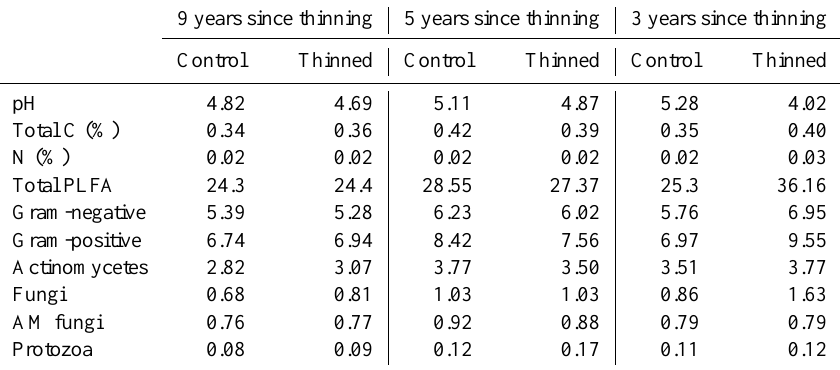
Table 2. Soil pH, C, N, and PLFA mean concentrations by year of harvest under grass ( N = 9). PLFAs are reported as nmolg − 1 dry weight. Means are reported without standard deviation or statistical significance as these data are pseudoreplicated. 9 years since thinning 5 years since